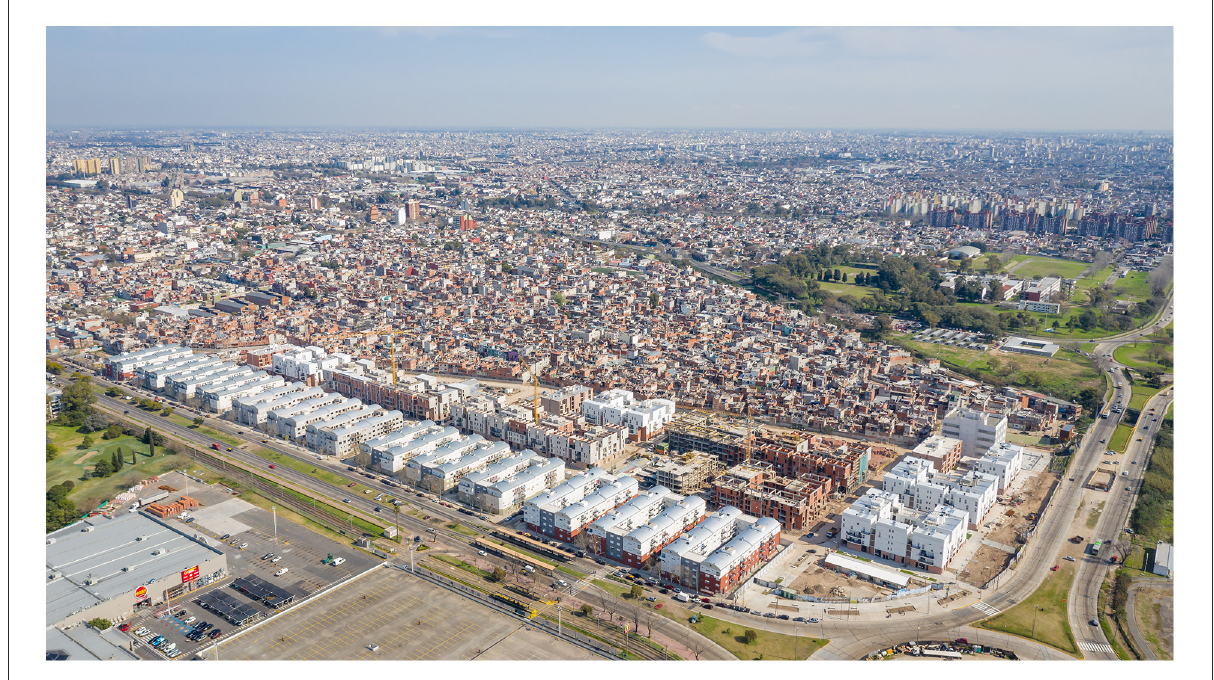
FIGURE1 View of Villa 20. Source: IVC